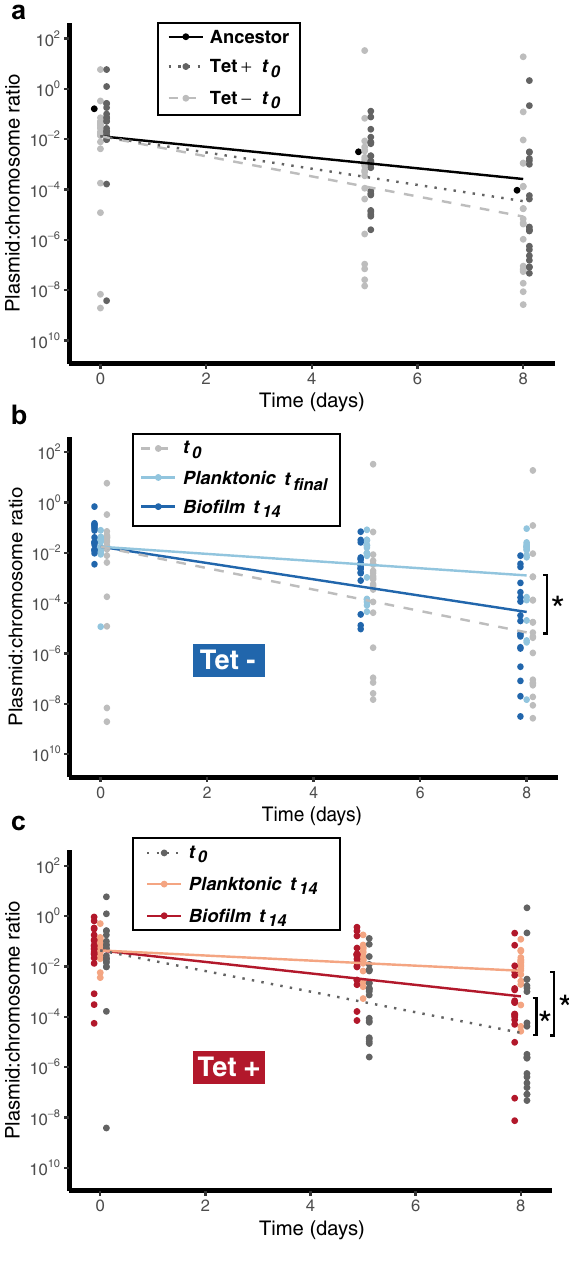
Fig. 2 Plasmid persistence shown as the estimated ratio of trfA / 16S rRNA genes over a period of eight days in liquid serial batch cultures in the absence of selection. a The ancestor used to inoculate the fl ow cells at t − 4 compared to clones isolated from all the bio fi lms harvested after four days of growth with tetracycline, t 0 , showing similar plasmid persistence dynamics (Tet + and Tet − : populations treated with and without tetracycline after t 0 ); b clones isolated from the Tet − populations, showing a drastic increase in plasmid persistence after evolution in planktonic but not in bio fi lm populations (note that two of the three planktonic populations no longer contained detectable plasmids after day 6 and 10, respectively, requiring analysis on these days instead of t 14 — the fi nal sampling times are therefore referred to as t fi nal ); c clones isolated at t 0 and t 14 of the Tet + evolution experiment, showing an increase in plasmid persistence over time for all populations. Lines are the output of the log-linear model for each group. *Denotes a signi fi cant difference ( t -test p -value < 0.05) between the groups pointed out by the brackets: planktonic, t fi nal versus t 0 , and bio fi